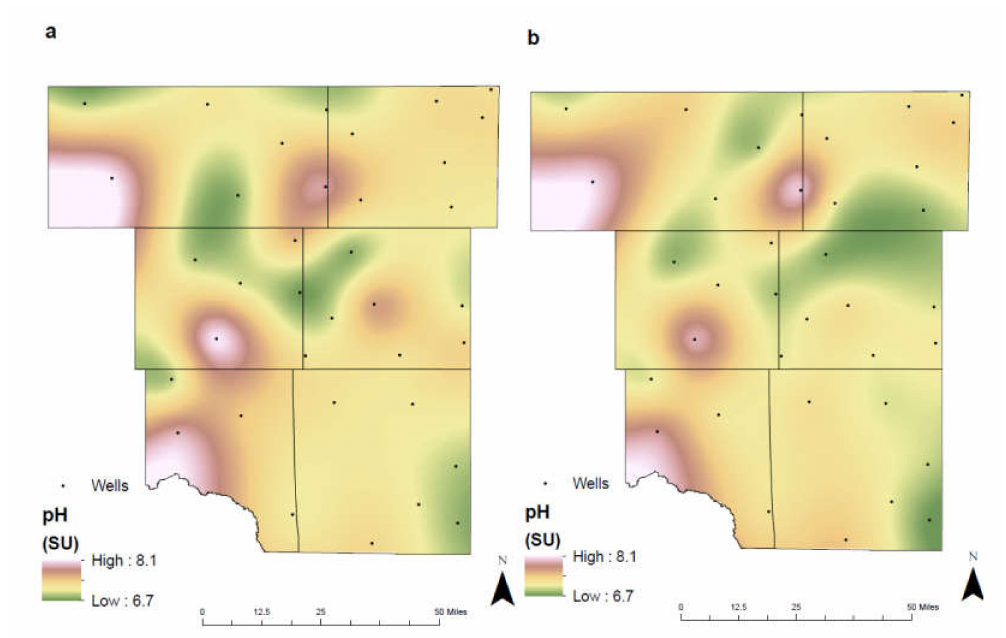
Spatial distribution of pH in the study area for ( a ) 1992–2005 and ( b )